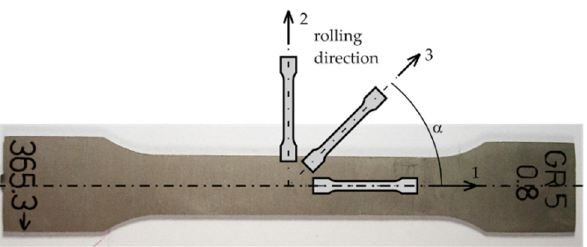
Figure 2. Scheme of taking samples cut from a sheet at different angles to the rolling direction: 0° (1), 45° (3) and 90° (2).